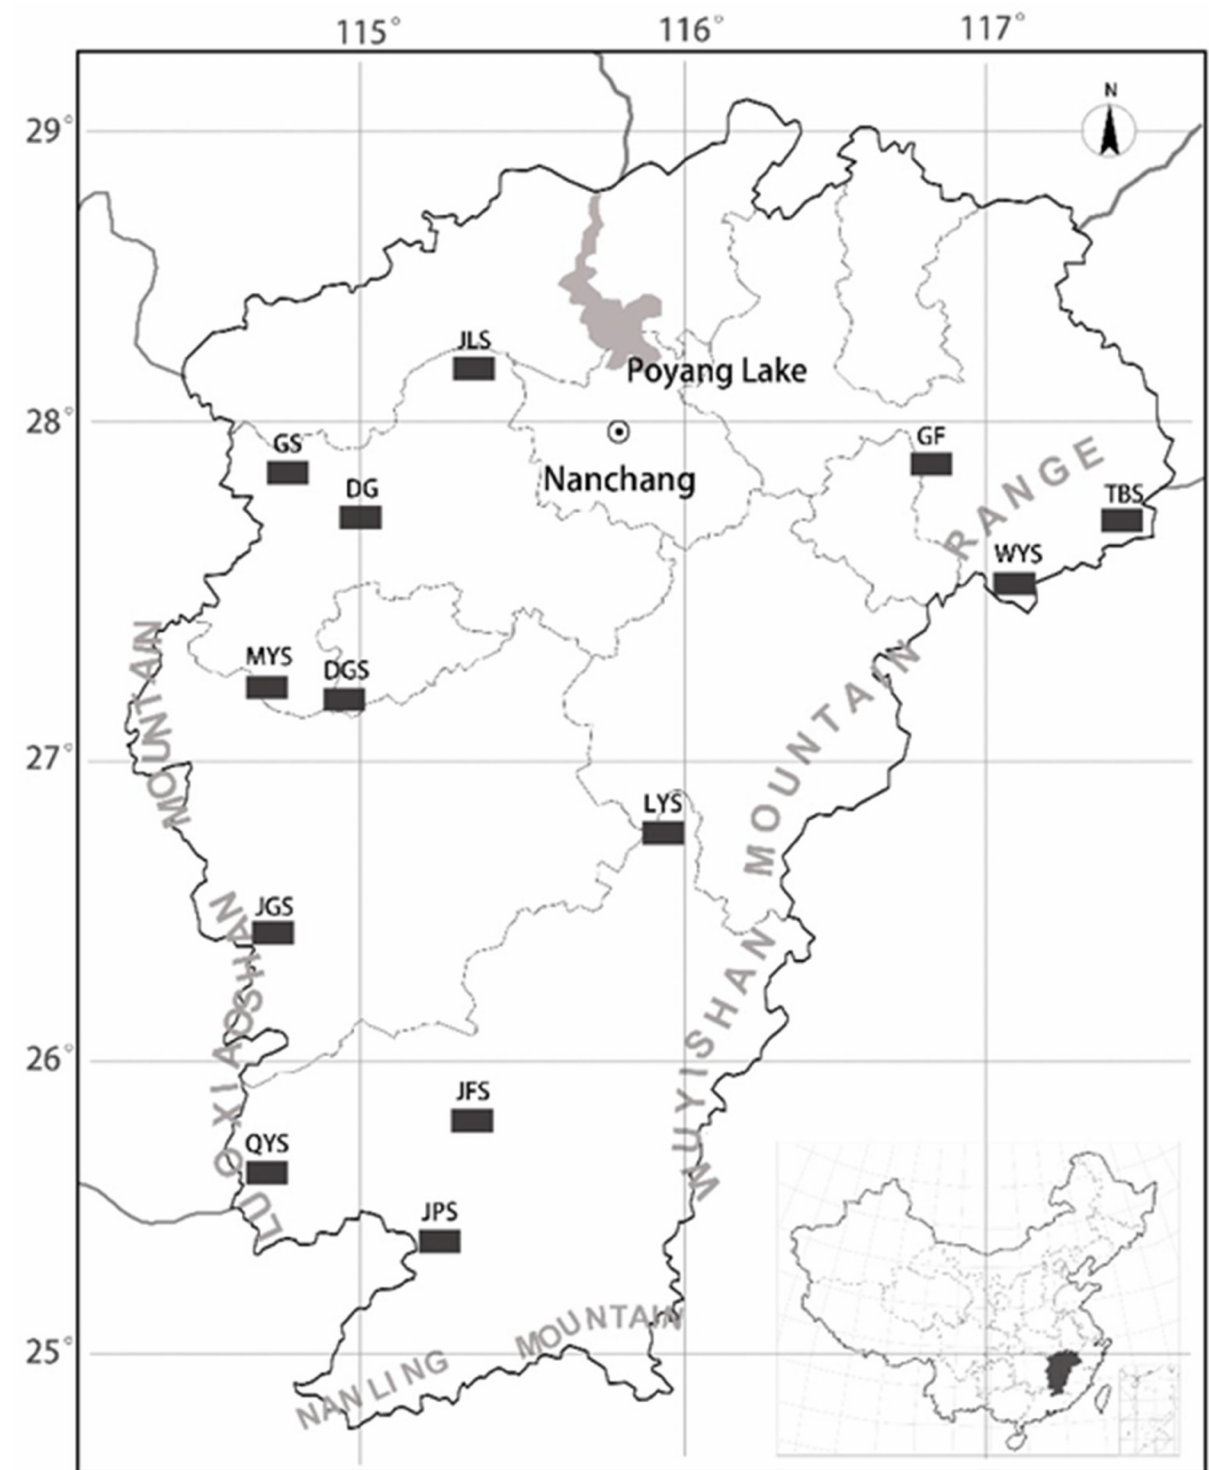
Figure 1. The 13 localities for 58 bamboo–woodland interfaces in this study of Jiangxi Province. DG—Dagang Forestry Station, DGS—Dagangshan Forest Ecological Station, GF—Guifeng Forest Park, GS—Guanshan Nature Reserve, JFS—Junfengshan Forest Park, JGS—Jinggangshan